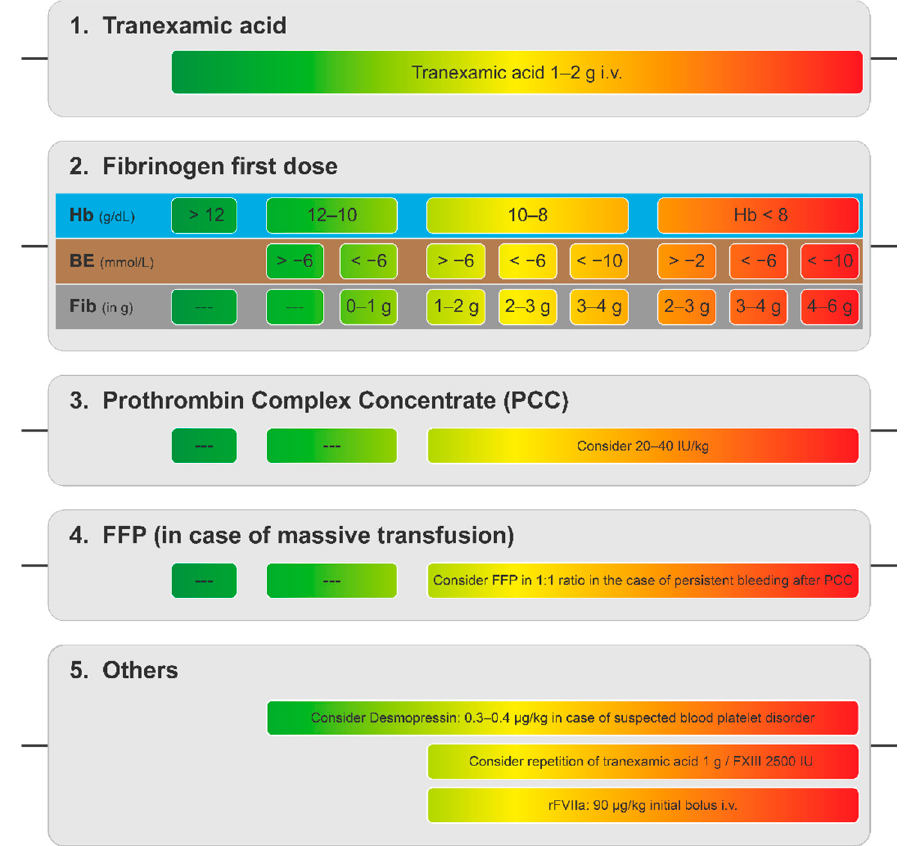
Figure 3. Decision tree for dosing of haemostatic agents without the use of VET. Adapted from Casu S, 2021 [107]. Reprinted by permission from BMJ as indicated in the Terms and Conditions of the